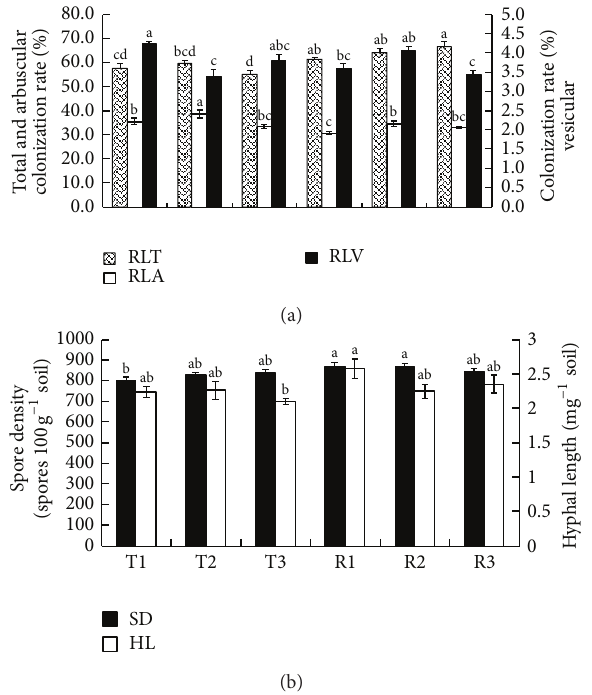
Figure 2: AM colonization rates in citrus roots, spore density, and hyphal length in trifoliate orange (T) and red tangerine (R) rootstocks orchards. (a) The ratio of root length with arbuscules (RLA), vesicles (RLV), and total AM colonization (RLT); (b) spore density (SD) and hyphal length (HL). Bars with the different letters show significant differences at the 0.05 level.